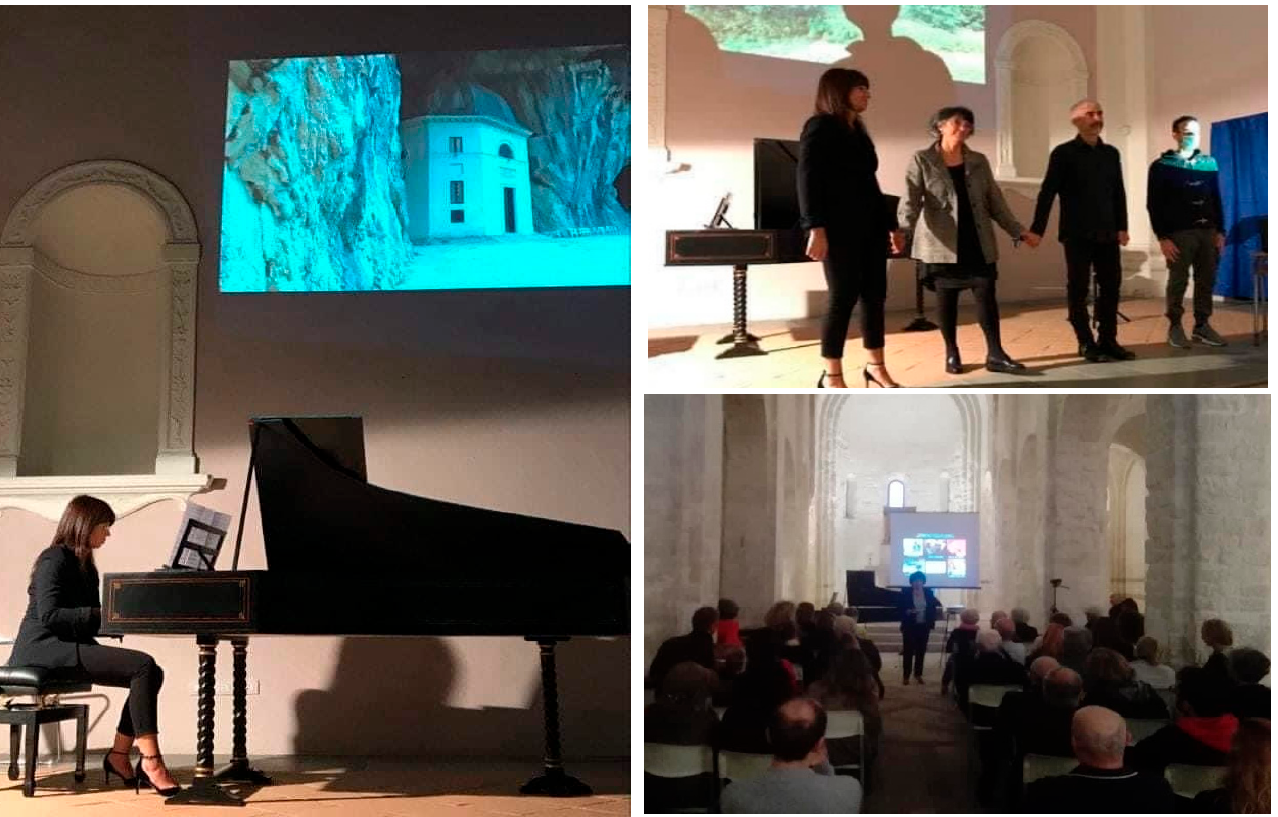
Figure 3. Images from one of TerreRare live events that combine scientific communication with the reading of poems, and the live performance of music. The musical and poetic performances are conducted in front of a large screen with projections of images and videos of the places, resulting in a total emotional participation of the public.